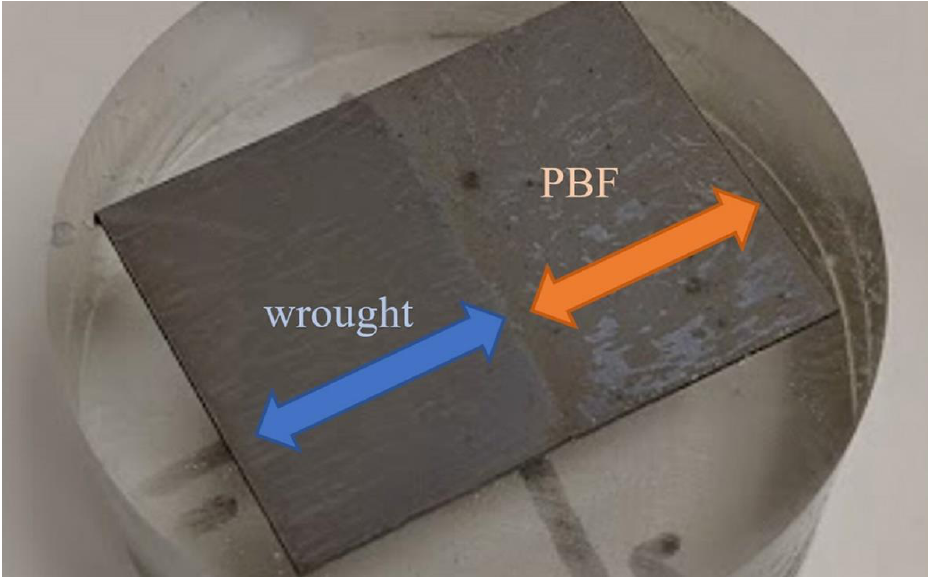
Figure 3. Etched PBF/wrought SS316L microscopy specimen.